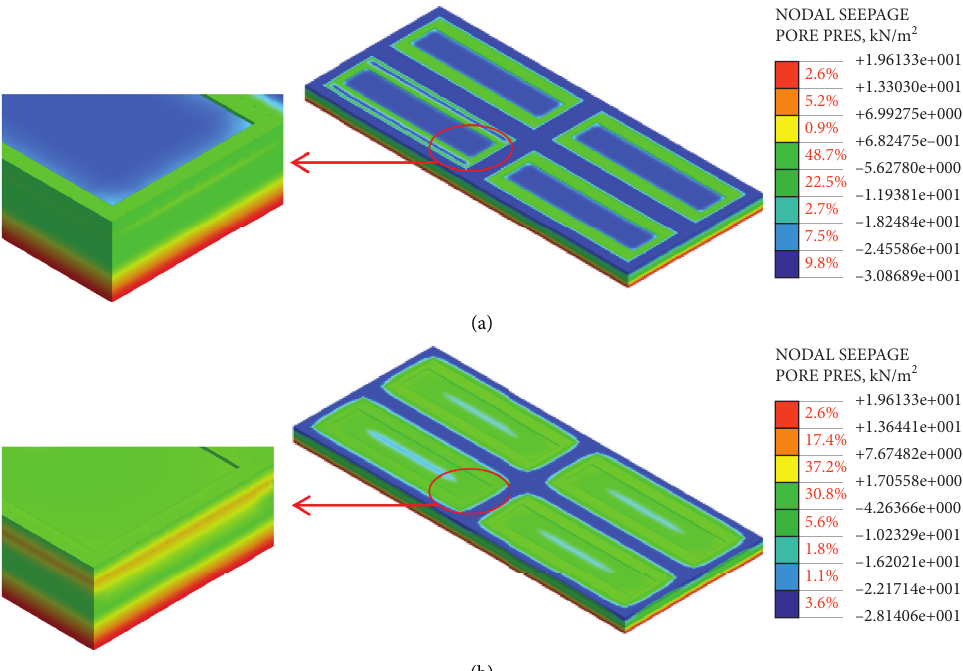
Figure 21: Pore water pressure nephograms of buildings when seepage wells are placed around building 1 following (a) 10min and (b) 120min of rainfall in the numerical model (the color of the legend represents the pore water pressure range. The value of the legend represents the pore water pressure value. The red % represents the volume percentage of color legend in the whole numerical model.).